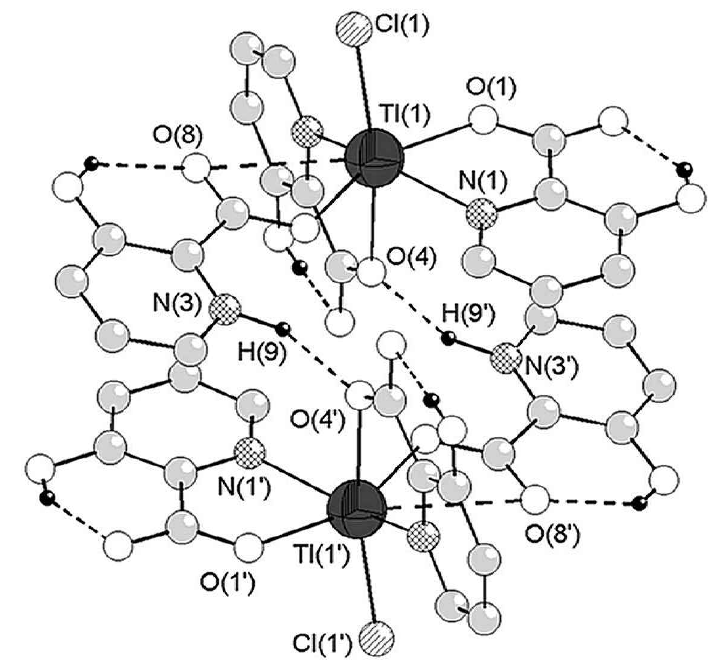
Fig. 6 Dimer association through hydrogen bonding in 4